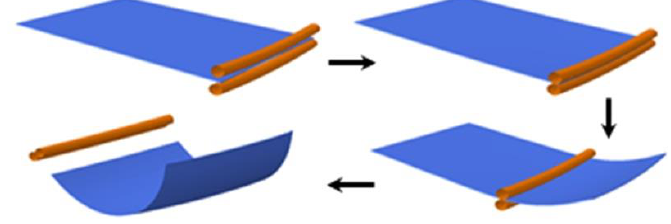
Figure 2. Continuous roll forming process.